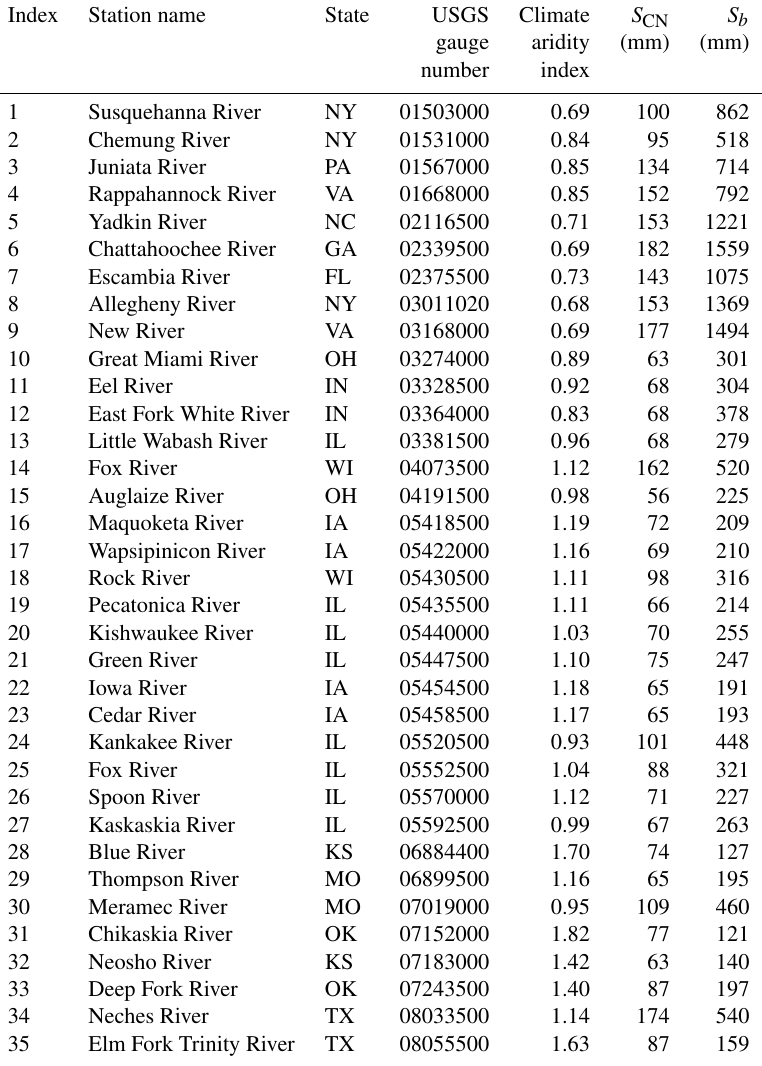
Table 1. The USGS gauge stations, climate aridity index, the estimated potential maximum retention of curve number method ( S CN ), and the average soil water storage capacity ( S b ) for the study